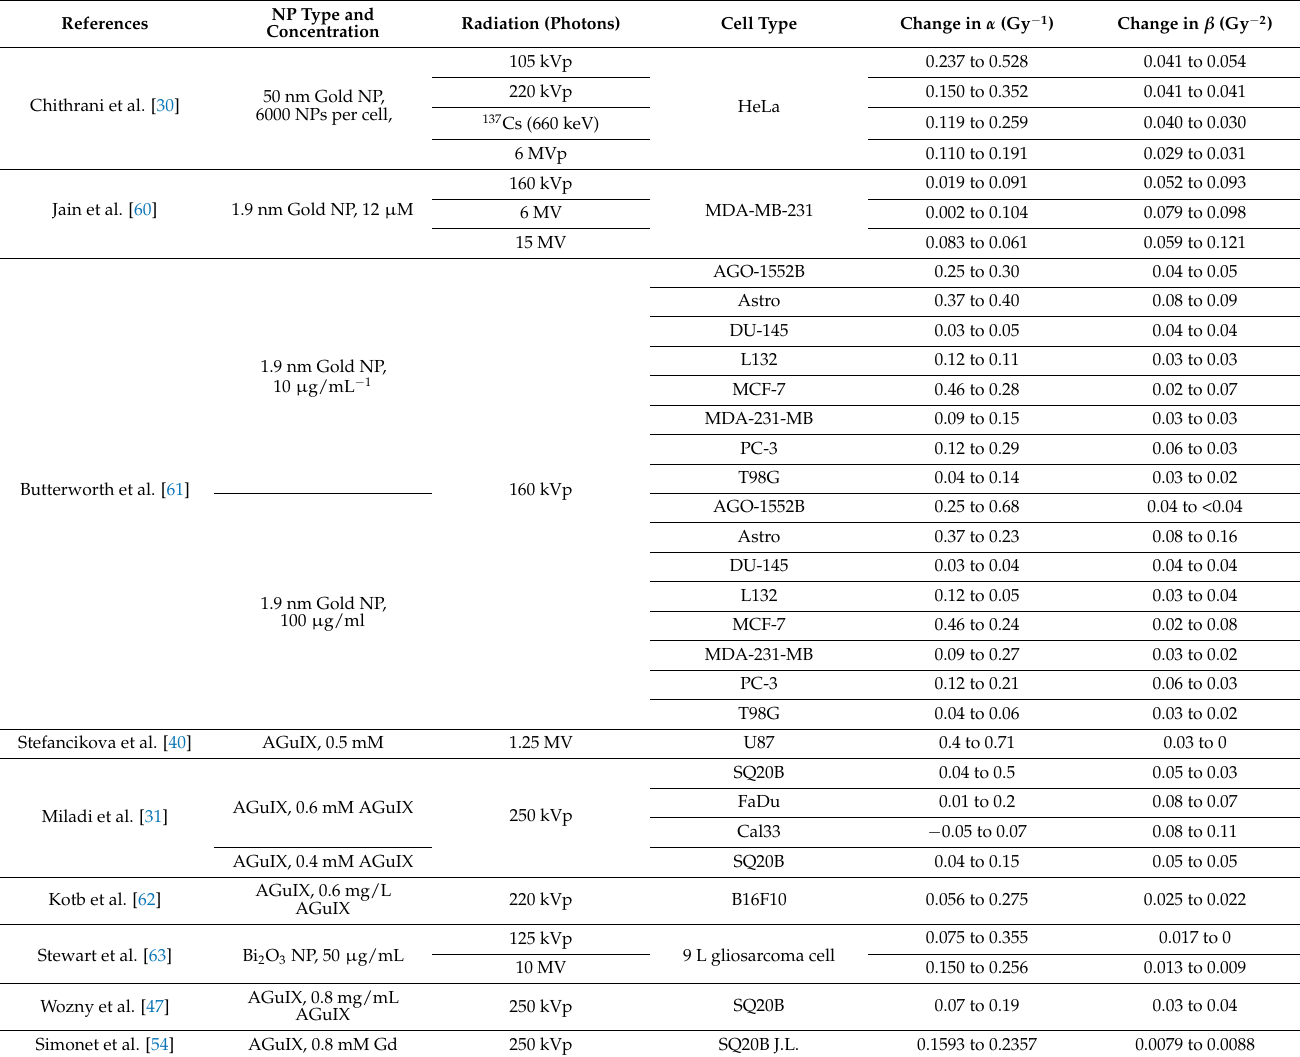
Table 4. Changes in α and β reported by some literature on NP